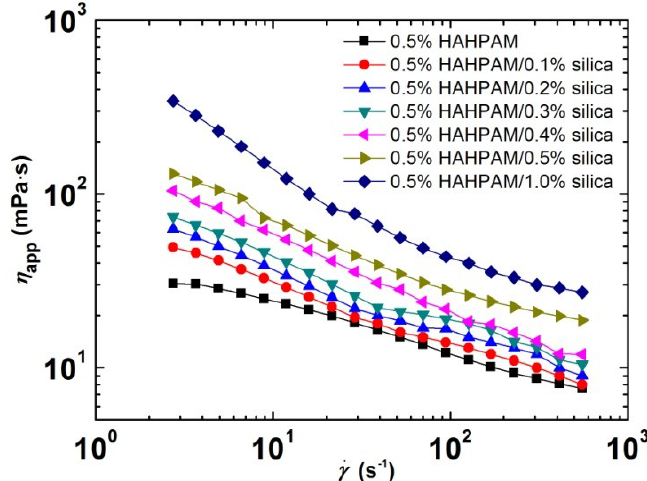
Figure 3. Apparent viscosity plotted as a function of shear rate for HAHPAM/silica hybrids in brine with different silica loading (TDS = 32,868 mg∙L −1 , [Ca 2+ ] + [Mg 2+ ] = 873 mg∙L −1 , T = 85 °C, C = 0.5 wt%). p